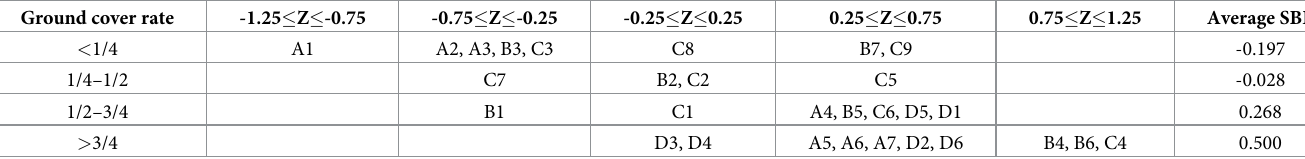
Table 8. SBE scores of samples based on the ground cover